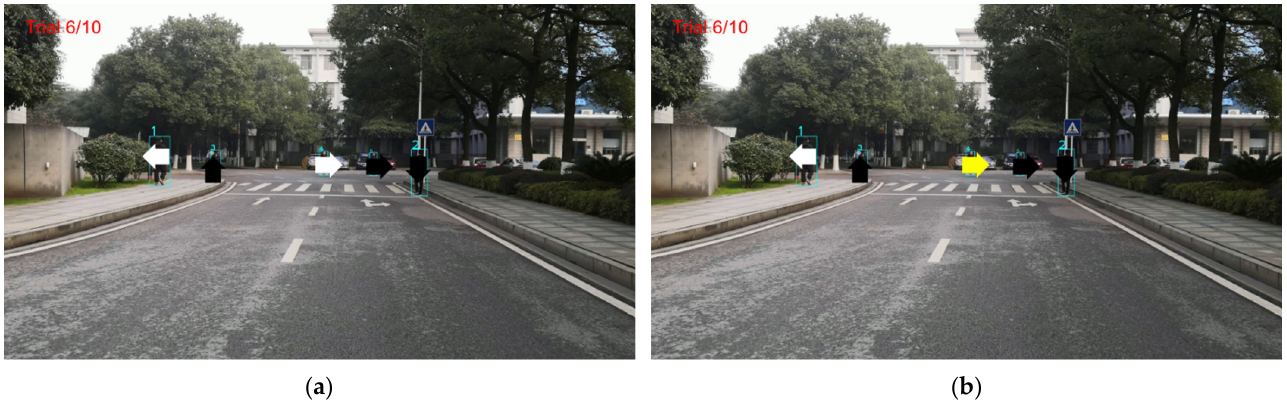
Figure 2. Stimuli presentation interface of hybrid BCI system on trial 6 of a block. ( a ) Arrows in different directions are randomly superimposed on pedestrians according to the frequency list corresponding to the ID order; ( b ) Subjects select the threatening object, and the arrow stops flashing and turns yellow.